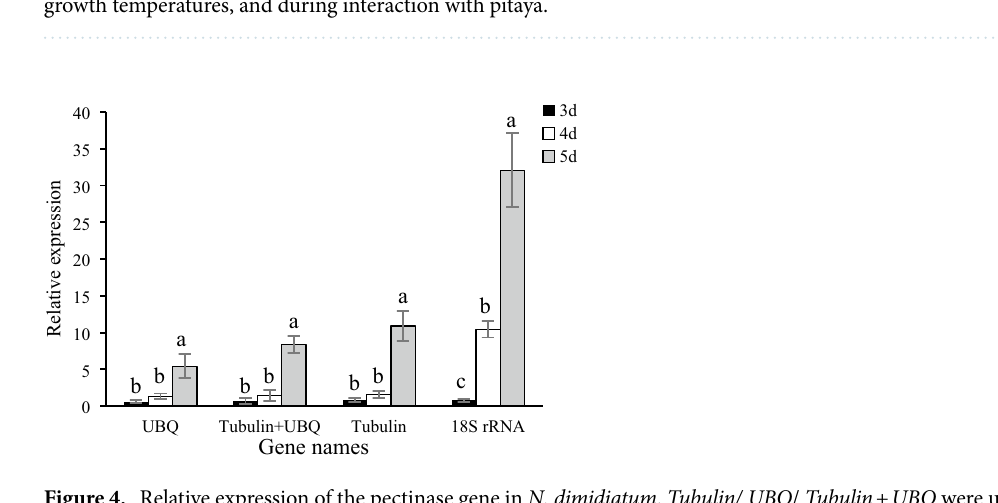
Figure 4. Relative expression of the pectinase gene in N. dimidiatum . Tubulin/ UBQ / Tubulin + UBQ were used as one or two stable reference genes. The expression of the reference gene 18S rRNA was the least